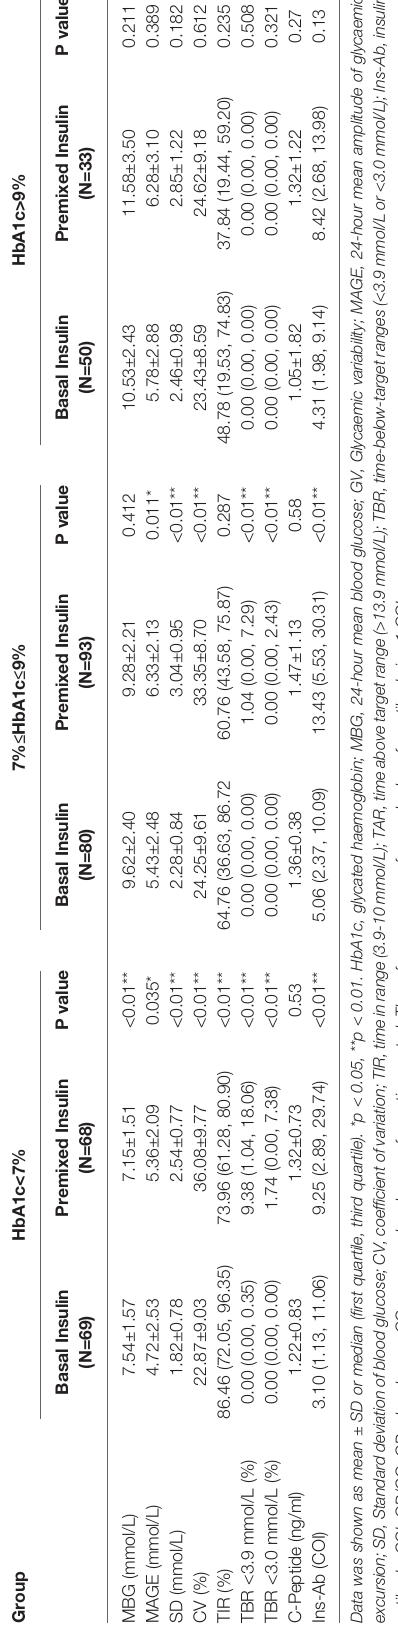
TABLE 5 | Clinical characteristics of patients with subdivided basal insulin group.